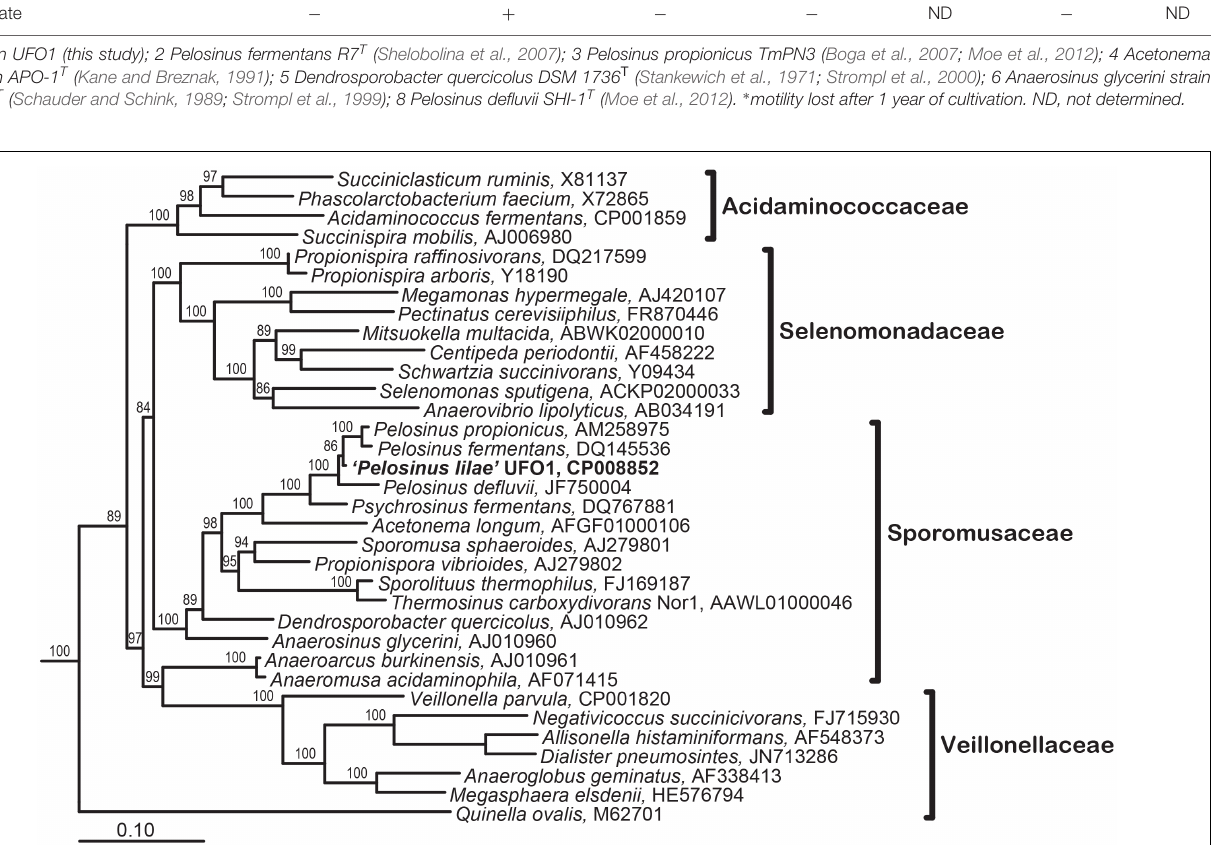
Frontiers in Microbiology |